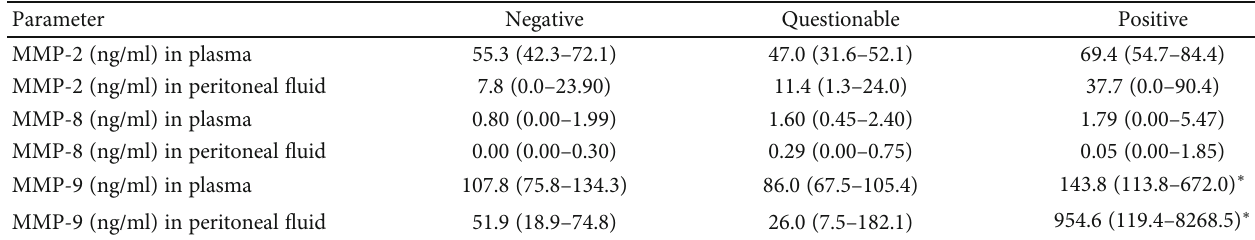
Table 4: MMP-2, MMP-8, and MMP-9 concentrations in plasma and peritoneal fl uid in the groups negative ( n = 32 , ≤ 6/19 points), questionable ( n = 8 , 7-9/19 points), or positive ( n = 6 , ≥ 10/19 points) for sepsis; median (lower quantile – upper quantile). Signi fi cant di ff erences in comparison with the sepsis negative group are marked as ∗